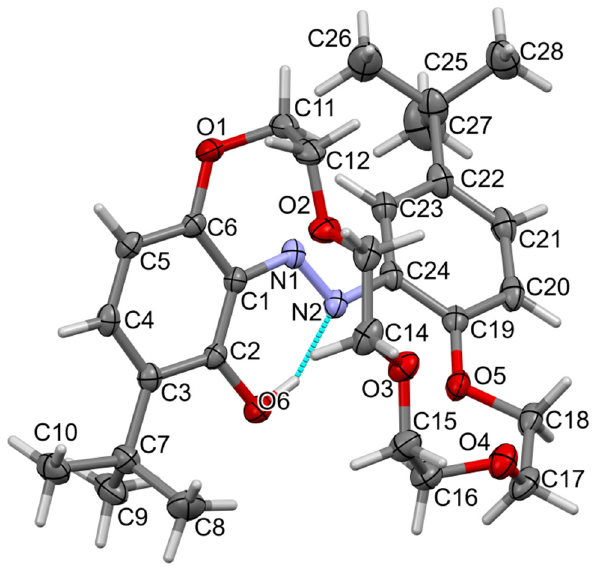
Figure 3. Molecular view of t -Bu-19- o -OH showing atom labelling scheme in one molecule, arbitrarily selected from the two symmetry-independent molecules in the structure. Intramolecular hydrogen bonding is drawn as the dashed cyan line. Displacement ellipsoids are drawn at a 50% probability level. Selected bond lengths (Å) and angles (°): N1-N2 1.276(2), N1-C1 1.401(2), N2-C24 1.422(2), C2-O6 1.352(2), C6-O1 1.370(2), C11-O1 1.449(2), C12-O2 1.422(2),C13-O2 1.416(2); valence angles: N2-